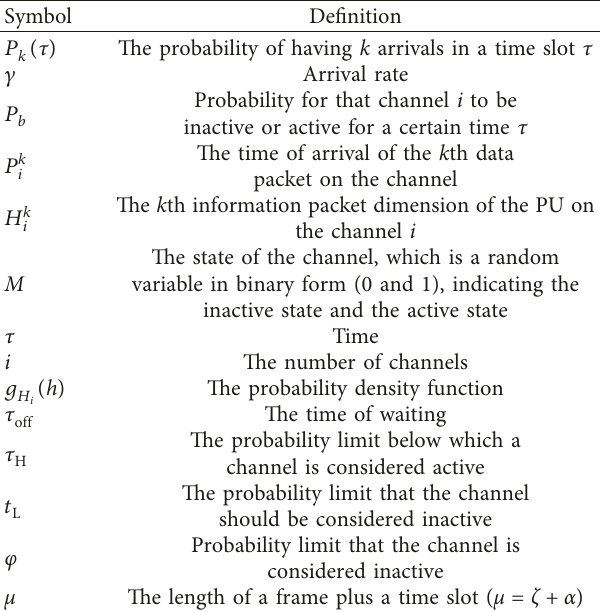
Figure 1: The process of spectrum handoff. Table 2: The symbols in the equations